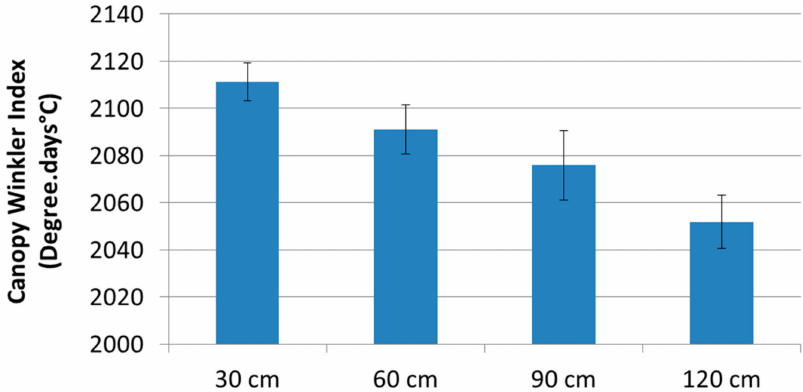
Figure 9. Variations in Canopy Winkler Index computed from temperature data acquired by sensors installed on vine posts at 30, 60, 90, and 120 cm in